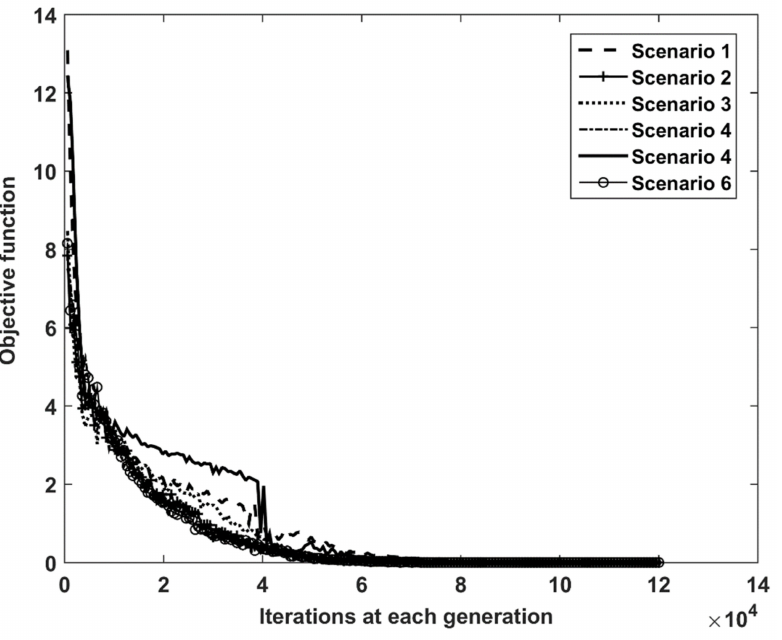
Figure 5. Convergence of the objective function for each sowing scenario during the optimization process.